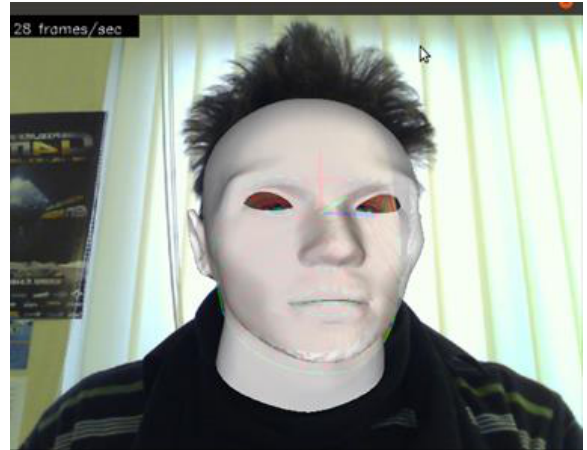
Figure 4. We have the projection of the 3D head model correctly superposed on the points from the face